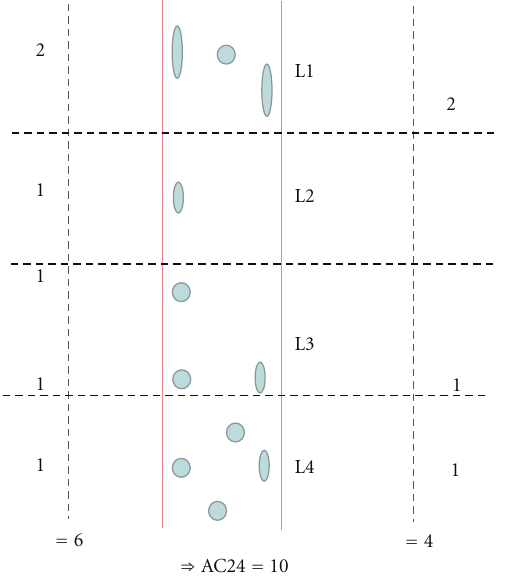
Figure 2: A schematic view of AC24. The AC24 is constructed by projecting the AAC to the corresponding aorta wall.